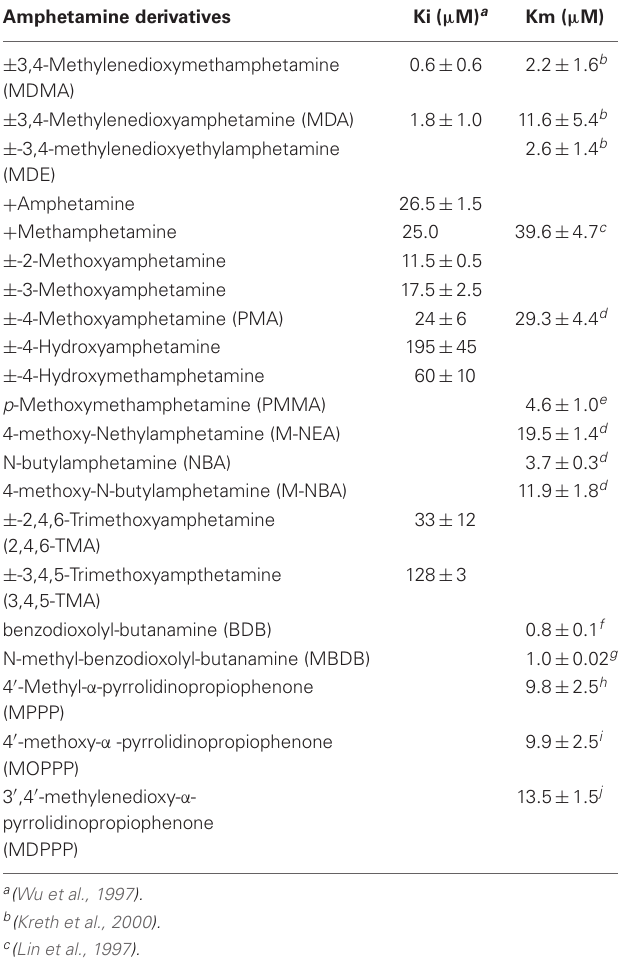
Table 1 | Interaction of amphetamine-like and related psychostimulants with CYP2D6: affinity and inhibitory